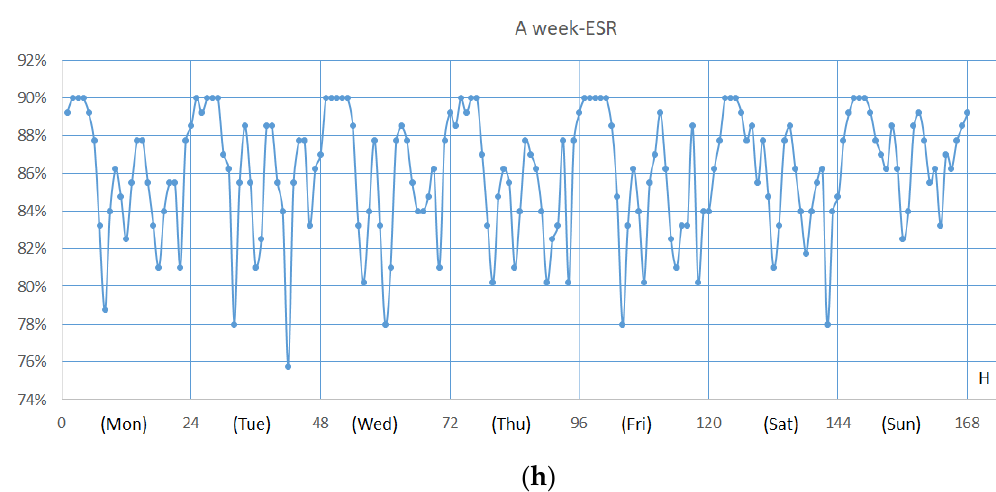
Figure 13. The measured hourly (H) ESR change chart of a parking lot. ( a ) Monday; ( b ) Tuesday; ( c ) Wednesday; ( d ) Thursday; ( e ) Friday; ( f ) Saturday; ( g ) Sunday; ( h ) whole week.